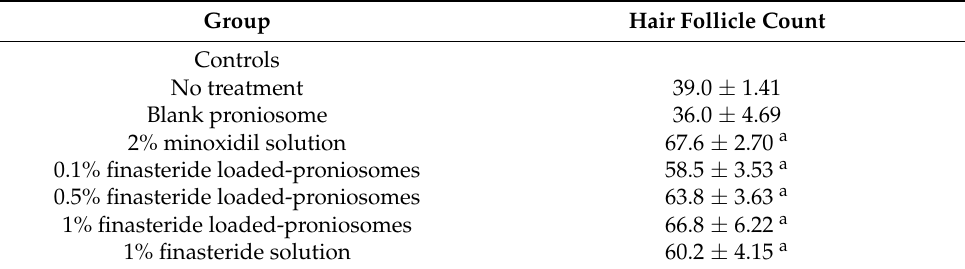
Table 6. The hair follicle counts of minoxidil, FLP, and FS treated C57BL/6